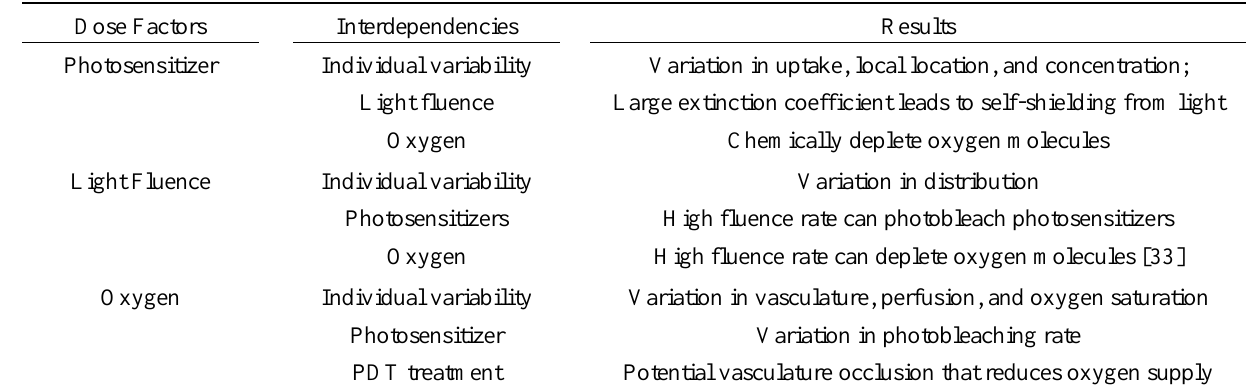
Table 1. Interdependencies of dose